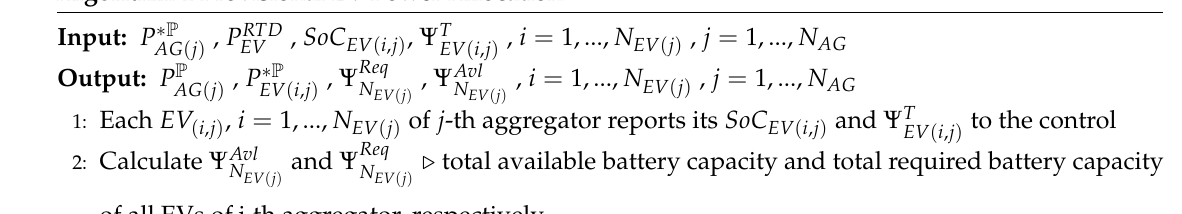
Algorithm 1 Provisional EV Power